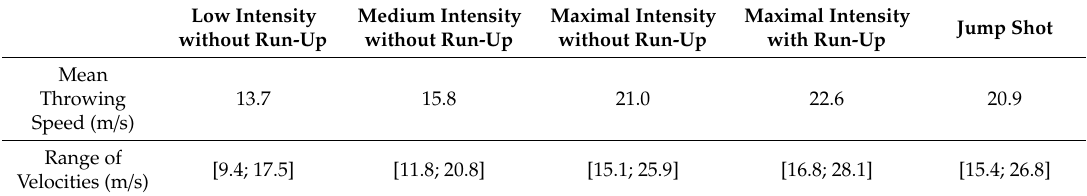
Table 1. Summary of throwing speeds for the five di ff erent types of